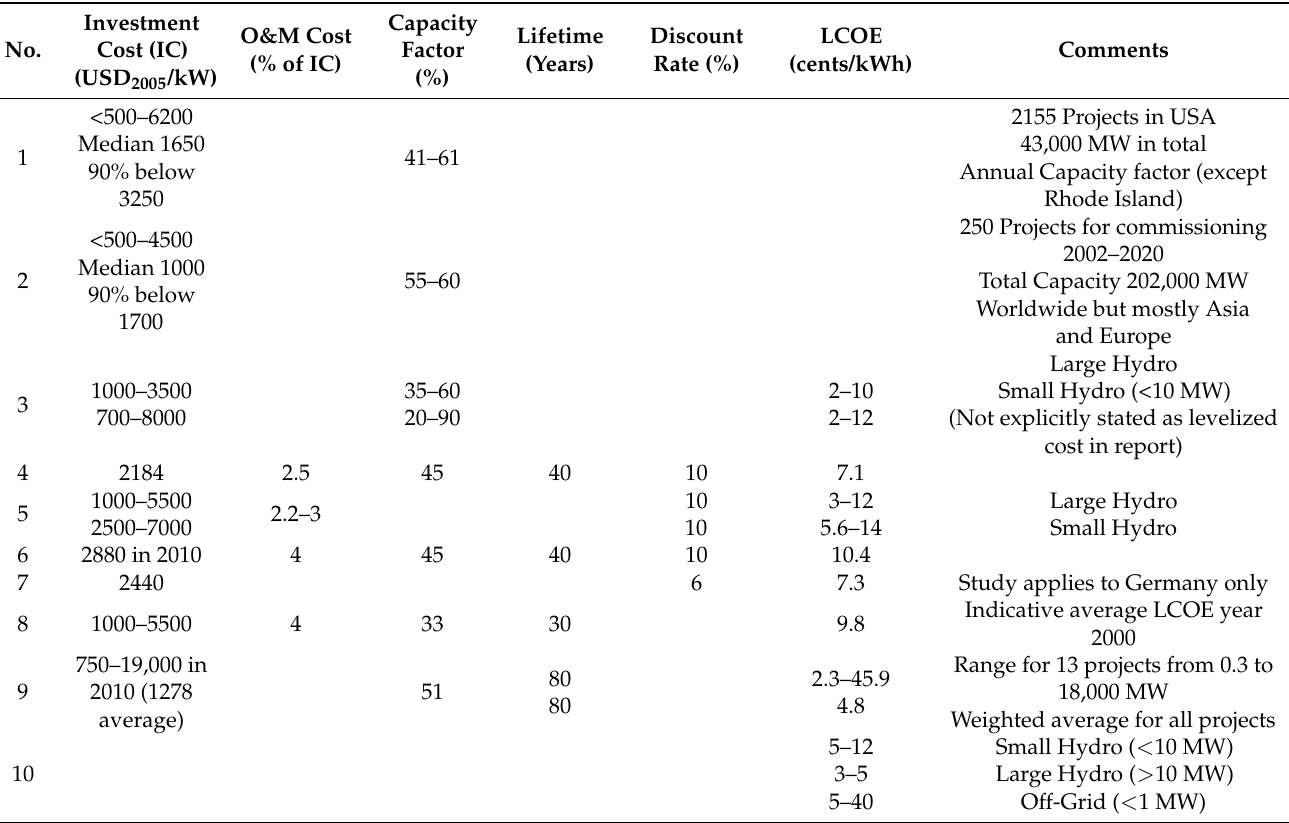
Table 16. General values of LCOE for hydropower projects